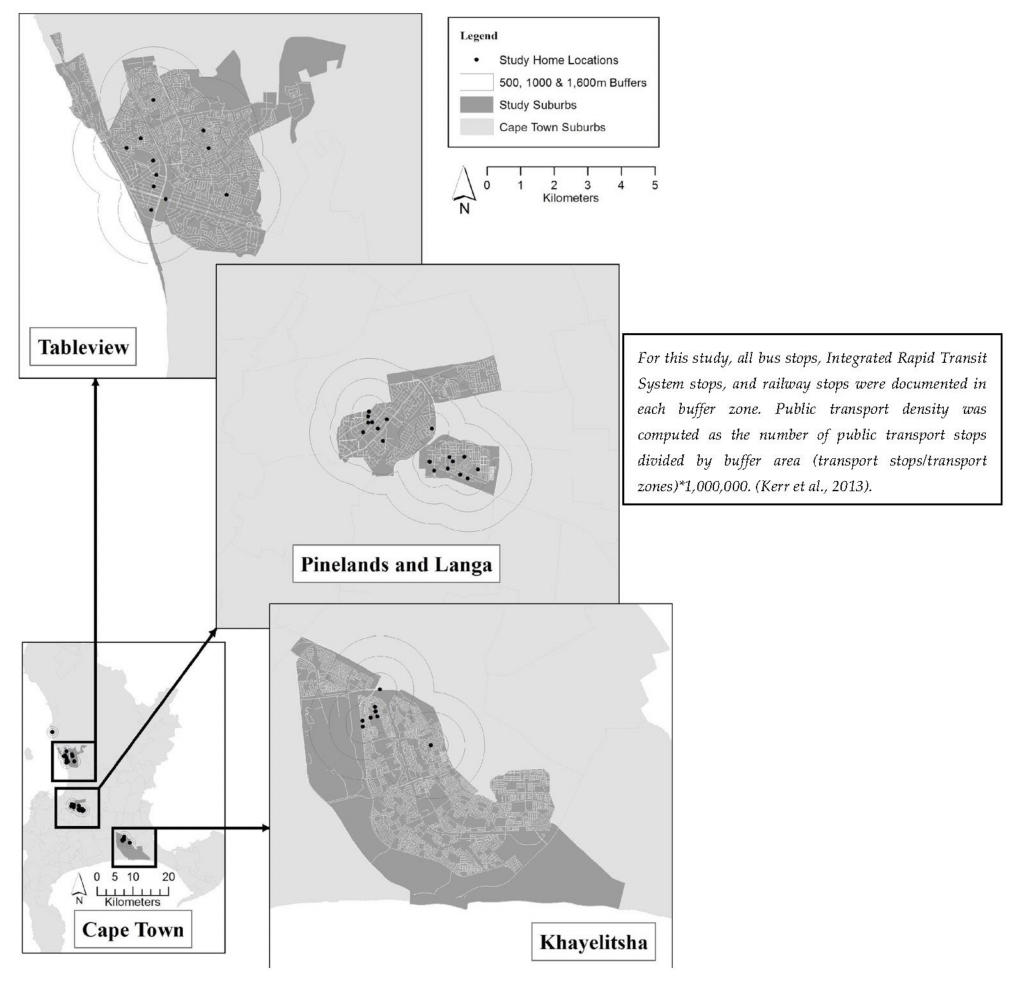
Figure 2. An overview of intersection density in the four study